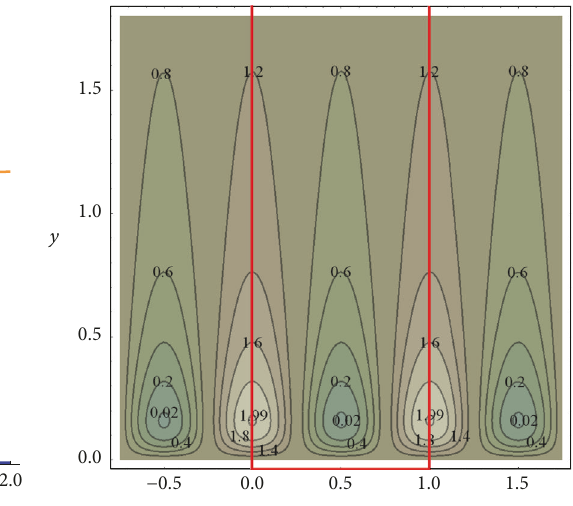
(b) Level plot of ̃Φ 0 /𝑀 0 . Higher values of ̃Φ 0 correspond to lighter tones. The fundamental domain D H is bounded by the red lines ̃Φ ̃Φ Figure 6: The lifted potentials ± and 0 .